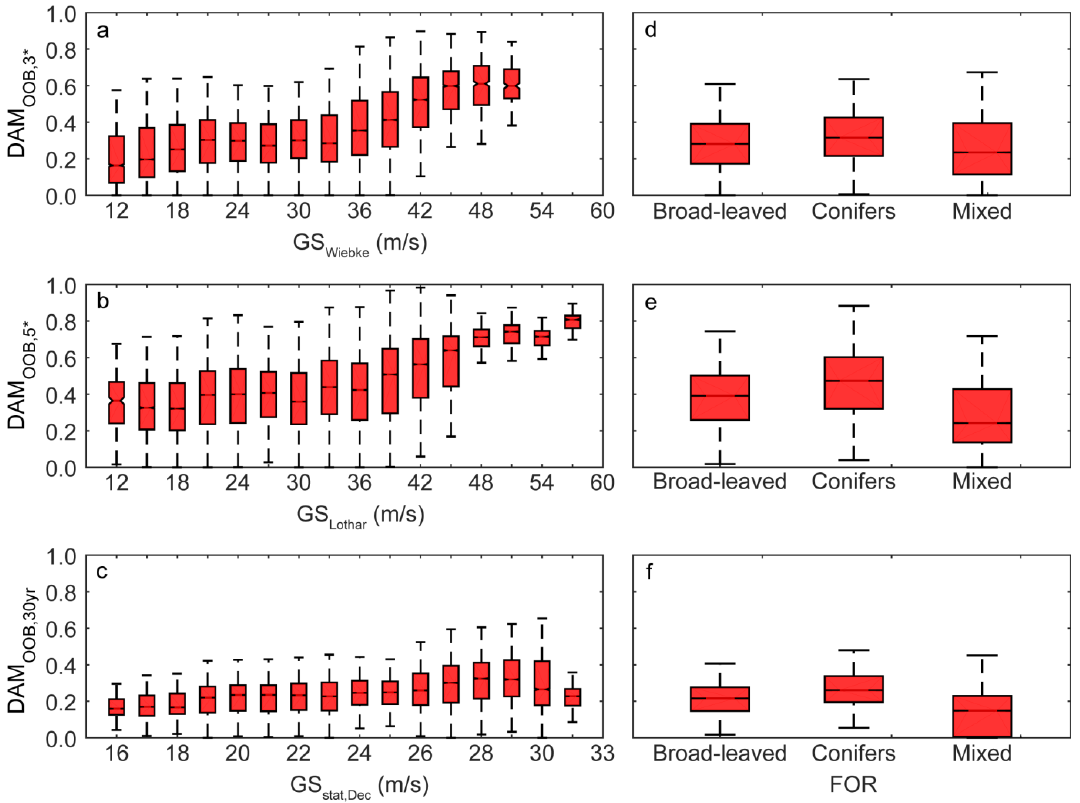
Figure 14. Boxplot of DAM OOB ,3 ˚ as a function of GS Wiebke ( a ); DAM OOB ,5 ˚ as a function of GS Lothar ( b ); DAM OOB ,30 yr as a function of GS stat , Dec ( c ); DAM OOB ,3 ˚ ( d ); DAM OOB ,5 ˚ ( e ) and DAM OOB ,30 yr as a function of FOR ( f )